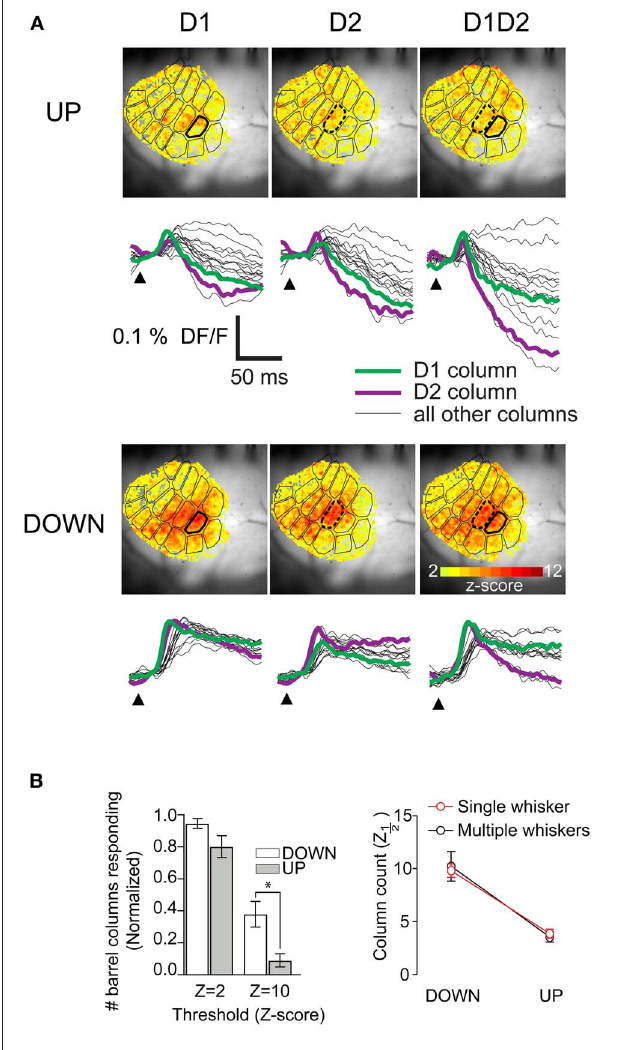
FIGURE 6 | Absence of significant differences between the columnar extent of two-whisker and one-whisker responses. (A) Maps of peak response at each pixel over 40ms poststimulus in response to the indicated whisker deflections in down- and up-states. Peak maps were constructed from averages of 15 recordings per state. (B) (Left) Barrel-column-averaged traces from same example as A . Statistically significant differences between up and down-state counts (Wilcoxon Signed Rank Test, p < 0 . 01) are indicated with the ∗ . (Right) Comparison of z 1 / 2 values in down- and up-states for single whisker and multiwhisker